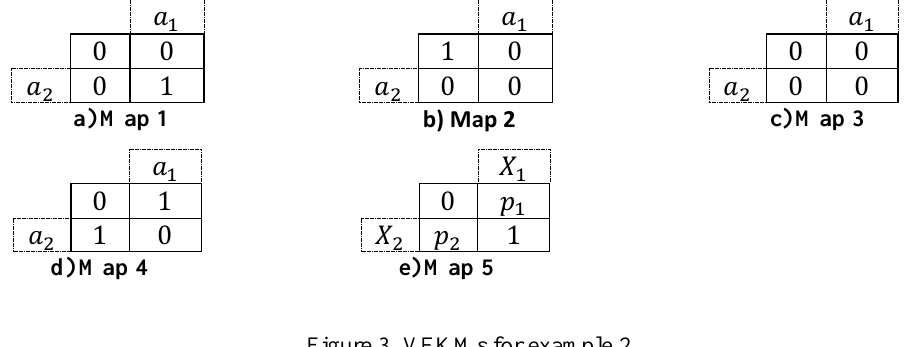
Figure 3. VEKMs for example 2